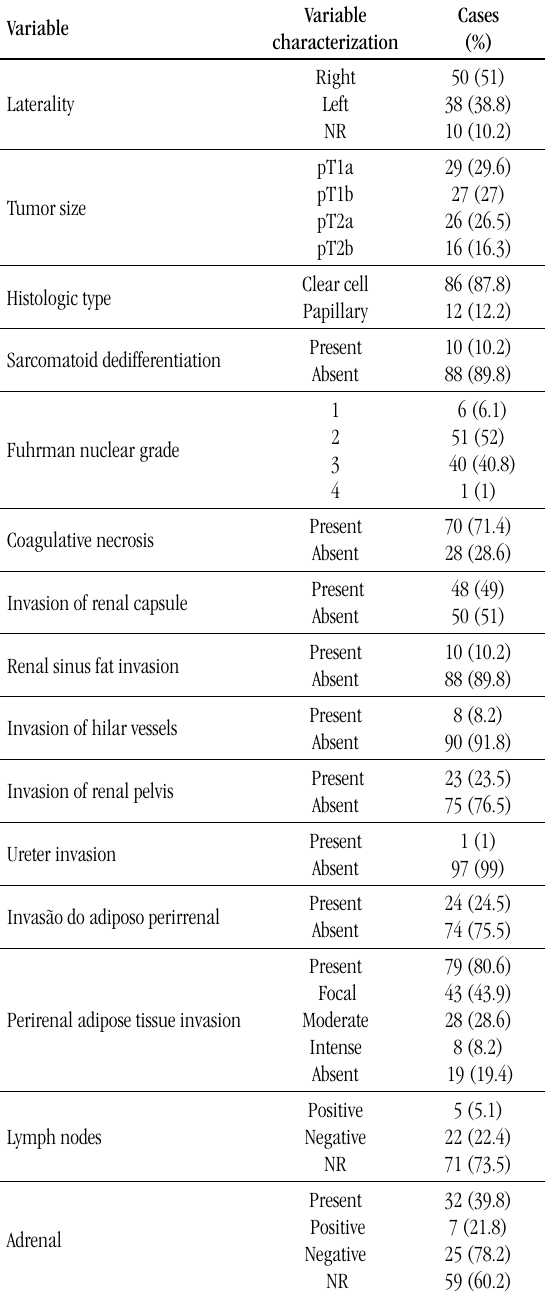
tABLE 1 – General anatomopathological aspects of 98 cases of renal cell carcinoma submitted to